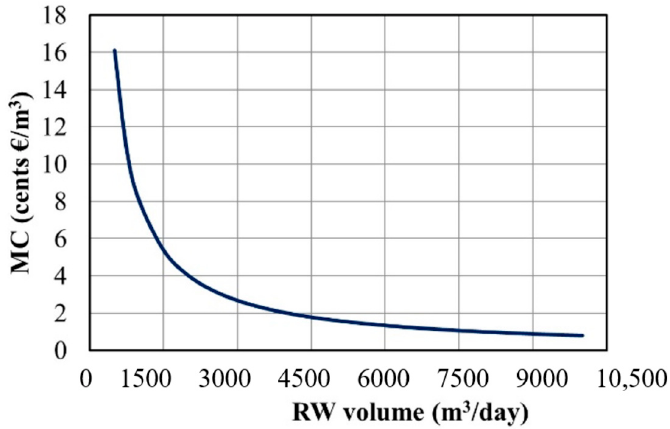
Figure 1. RW monitoring cost (MC) vs. RW volume.